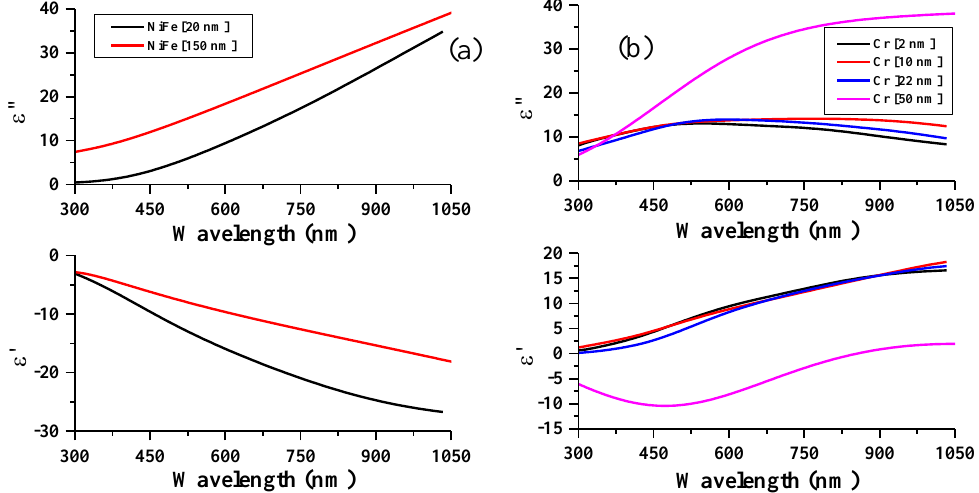
Figure 4. Real ( ε (cid:48) ) and imaginary ( ε ”) parts of permittivity for ( a ) NiFe and ( b ) Cr layers obtained from fitting the ellipsometry measurement of a two-layer film system. For comparison, the data for bulk materials (in the form of thicker films) are given [29,30].